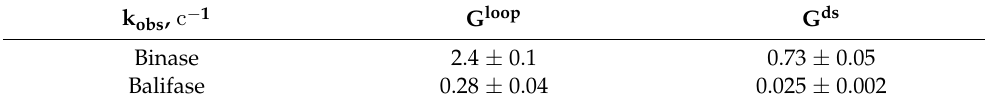
Table 3. Rate constant values for the interaction of binase and balifase with G loop and G ds